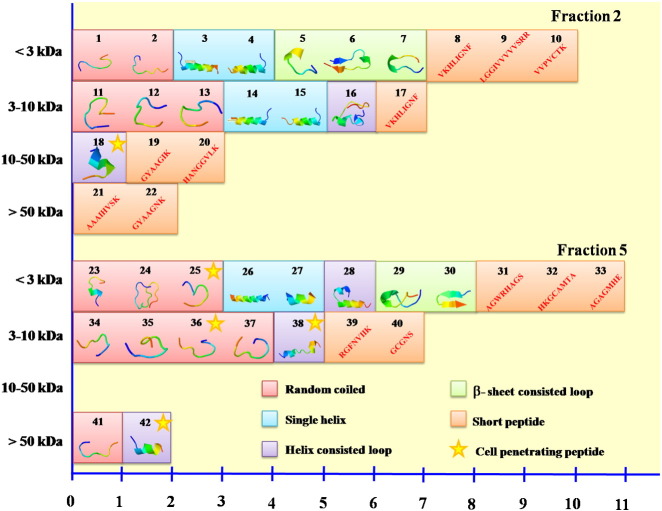
Structural predictions of the putative anticancer peptides obtained from the F2 and F5 fractions of the A. fulica mucus. These two fractions were separated into four sub-fractions: < 3 kDa, 3–10 kDa, 10–50 kDa and > 50 kDa. The peptide contents of these sub-fractions were analyzed by protein assay and mass spectrometry. All sub-fractions were trypsinized except the < 3 kDa sub-fraction. Putative anticancer peptides and their structures were predicted by bioinformatic programs and shown in this figure. The structures of these peptides were classified into five categories: random coiled, a single helix, helix-consisted loop, β-sheet-consisted loop and short peptide. Putative peptides predicted from the F2 fraction were displayed on the top half, while those of the F5 fraction were shown on the bottom half. The asterisks indicated the cell-penetrating peptides.